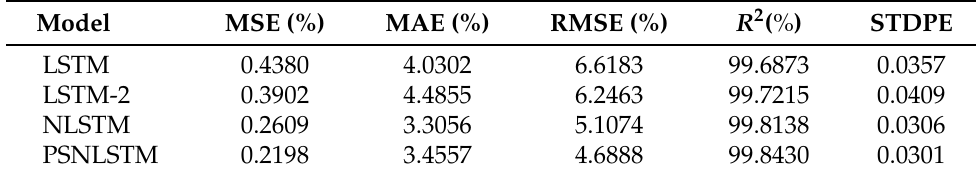
Table 5. The temperature prediction performance of ϑ SW